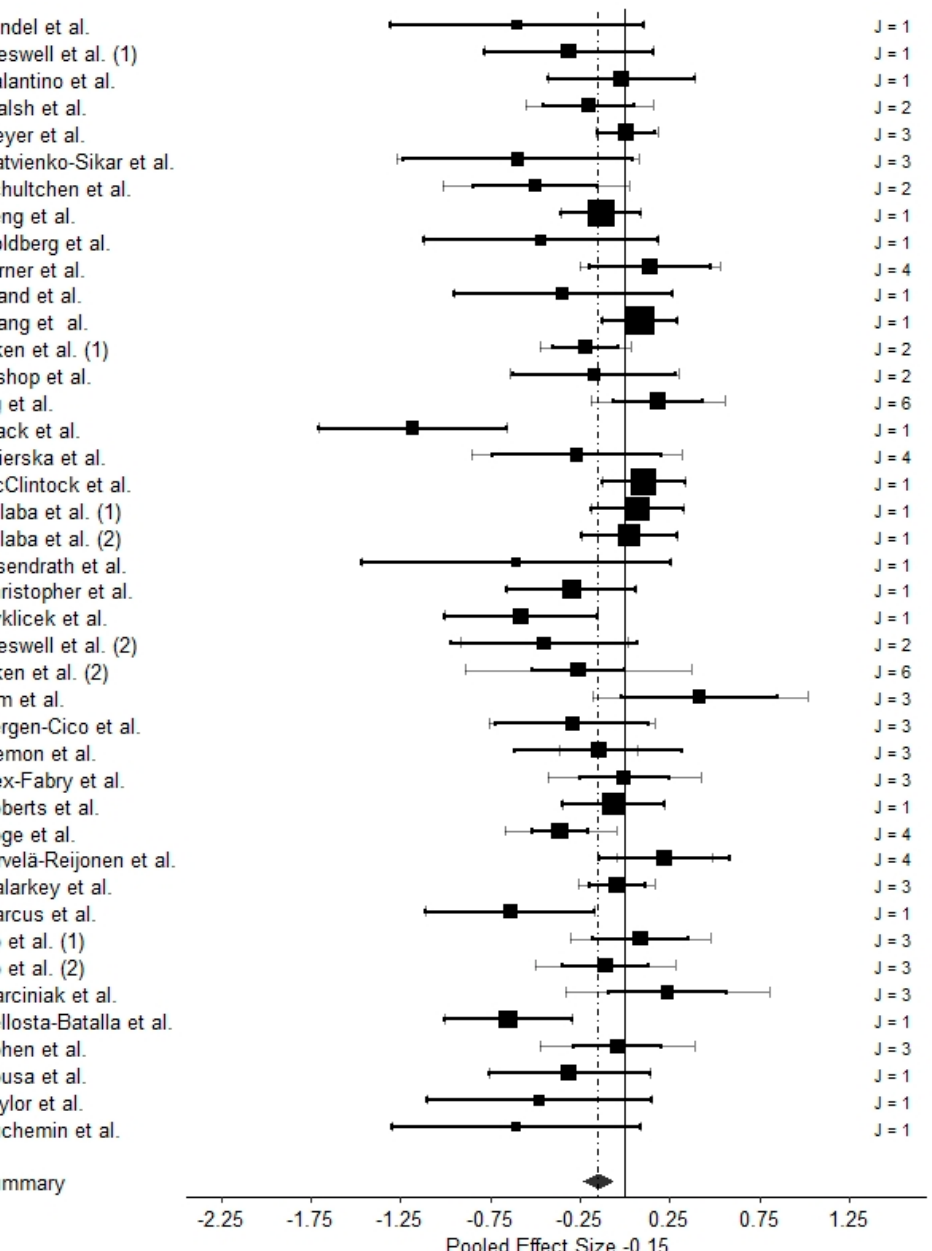
Figure 4. Three-Level Forest Plot of TLMA 1. Note. References of included studies are provided in Table 2. Numbers in parentheses refer to different samples of the respective studies (see Table 2 for details). Aggregated effect sizes on the study level (Level 3) are represented as squares, whose size indicates the weight for the meta-analytic pooled effect estimate; black lines represent 95% confidence intervals of the aggregated effect sizes within each study (Level 3); grey lines represent 95% confidence intervals of the median precision of each individual effect size (Level 2) within each study. The black diamond represents the pooled effect estimate with its 95% confidence interval. J is the number of biomarkers within each study.